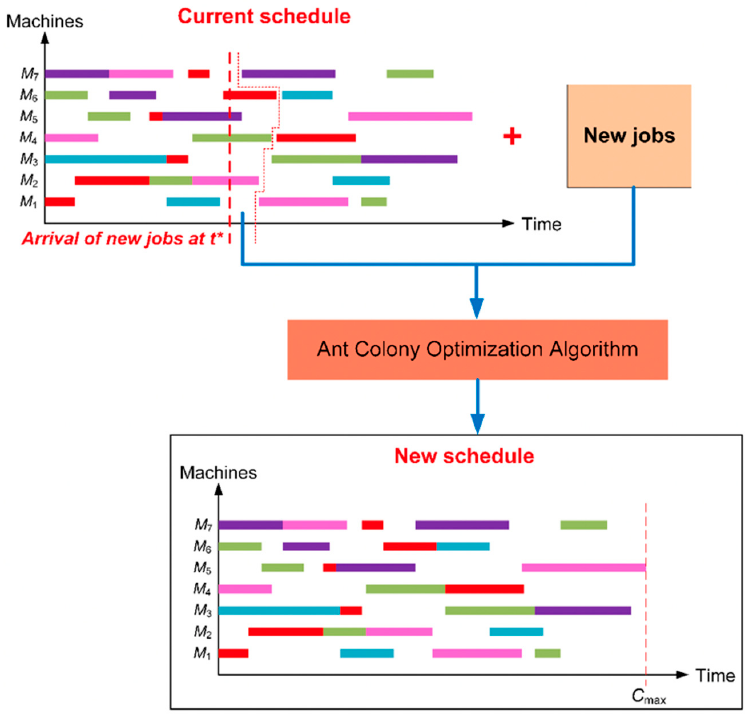
Figure 9. Dynamic scheduling problem illustration.